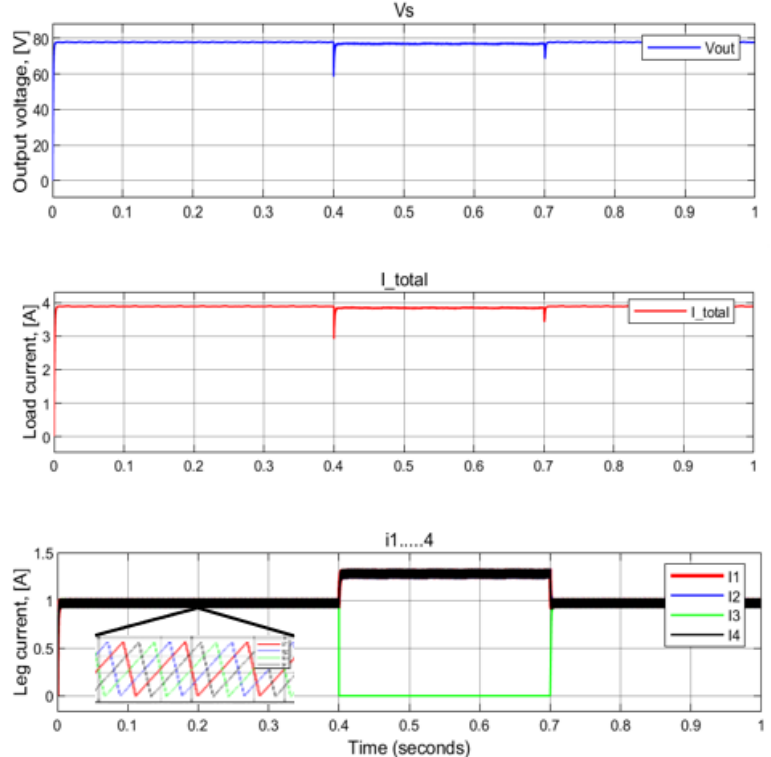
Figure 14. Output voltage, load current, and leg currents waveforms.